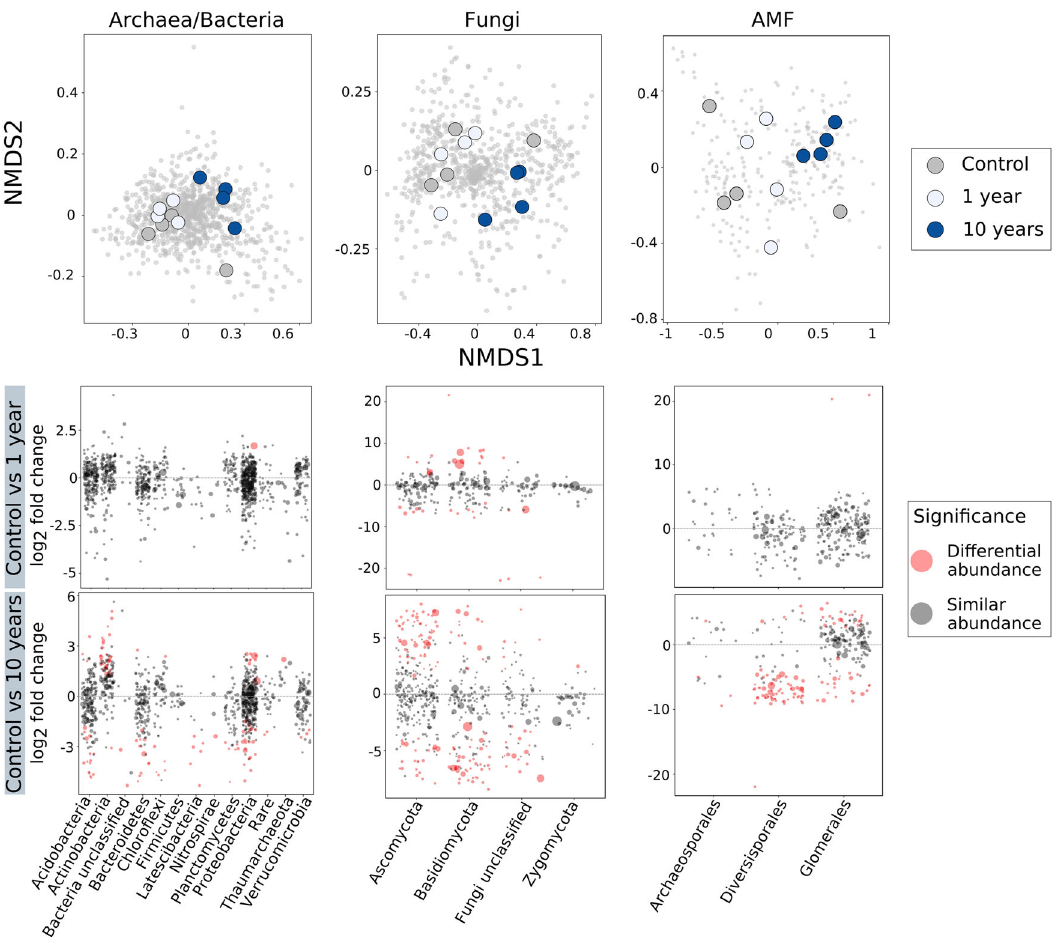
Fig. 2 Drought effects on microbial community composition assessed by amplicon sequencing. Colour indicates soil treatment (control = grey, 1 year = light blue, 10 years = blue). On top, graph NMDS representing archaea/bacteria, fungi and AMF (arbuscular mycorrhizal fungi). All the NMDS plots show the similar patterns, with an effect of drought (respectively, p = 0.014, p = 0.01, p = 0.015; PERMANOVA results , n = 4 ) and with a clear separation of the 10-year treatment from 1 year and control. The bottom graphs show results from the differential abundance analysis for control vs 1 year (top row) and control vs 10 years (bottom row). Circles in red represent taxa that had a signi fi cant differential abundance compared to the control , while in grey taxa that were not signi fi cant. Similarly to the NMDS plots, control vs 1 year results show little difference (only in the fungal community of Basidiomycota), while control vs 10 years shows strong differences at all levels (most affected groups being: Acidobacteria, Actinobacteria, Proteobacteria, Ascomycota, Basidiomycota, Diversisporales and